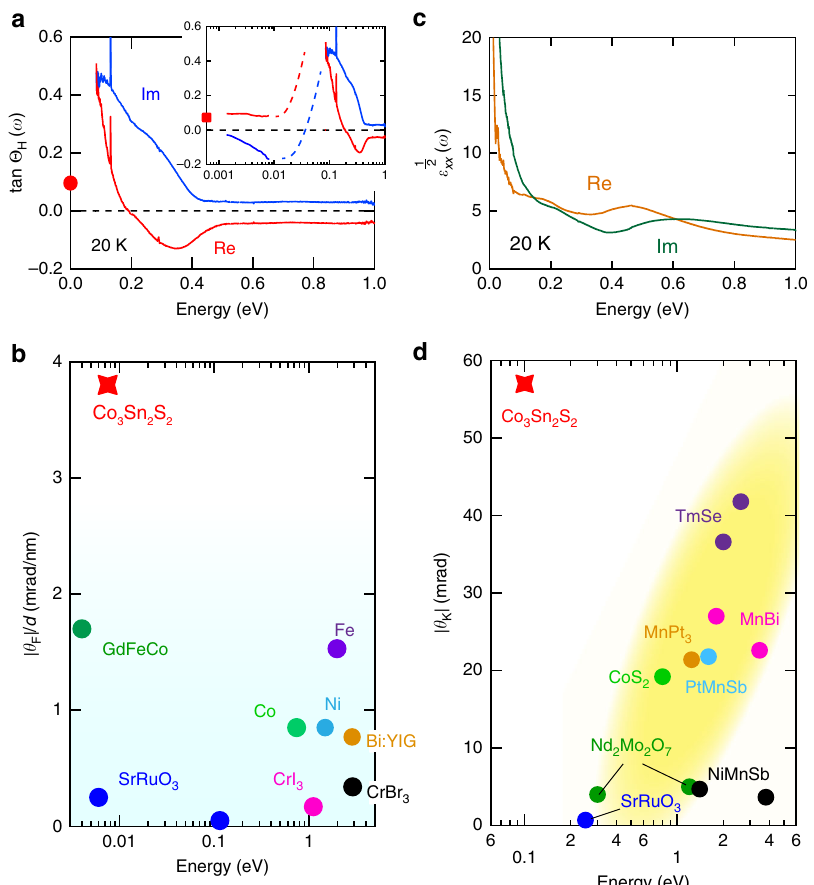
Fig. 4 Large magneto-optical responses due to Berry curvatures. a Hall angle spectra, tan Θ H = σ xy / σ xx . The red circle at zero frequency represents the DC value of the Hall angle of the bulk single crystal. The inset shows the Hall angle spectra including the terahertz spectra on the logarithmic energy scale. The red square at zero frequency represents the DC value of the Hall angle of the thin fi lm. b The peak magnitudes of the Faraday rotation angle divided by the sample thickness, d , for several ferromagnets. c Spectra of square root of the complex dielectric constant, ε xx 1/2 ( ω ). d The peak magnitudes of the Kerr rotation angle for several ferromagnetic